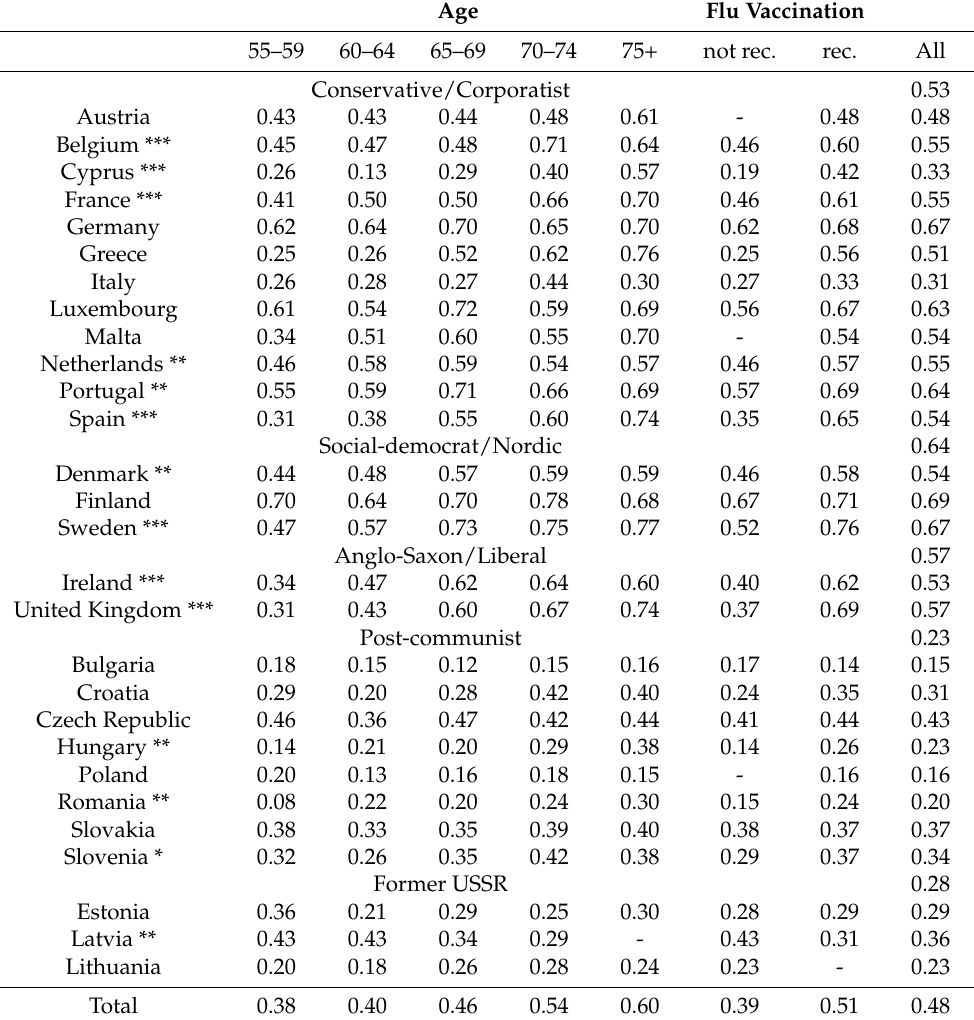
Table 1. Share of individuals who received a vaccination within the last five